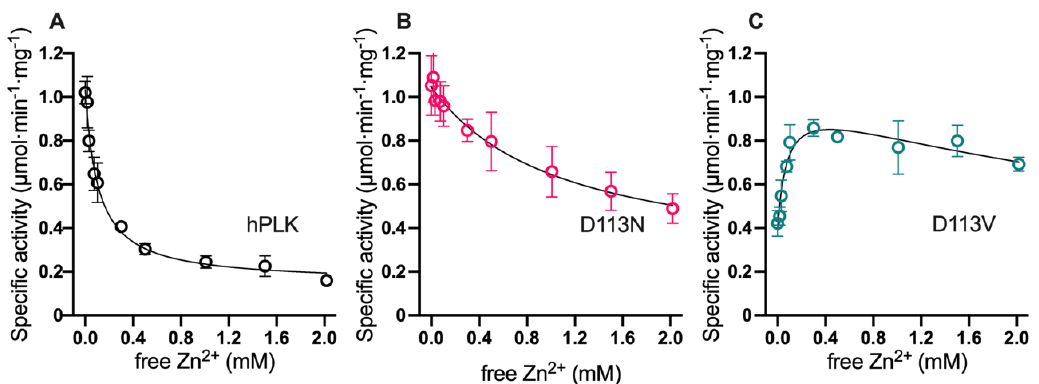
Figure 3. E ff ect of free Zn 2 + concentration on the activity of hPLK and DPV mutants. ( A ) Inhibitory Figure 3. Effect of free Zn 2+ concentration on the activity of hPLK and DPV mutants. ( A ) Inhibitory e ff ect of free Zn 2 + on wild type hPLK. ( B ) Inhibitory e ff ect of free Zn 2 + on D113N mutant. ( C ) Inhibitory effect of free Zn 2+ on wild type hPLK. ( B ) Inhibitory effect of free Zn 2+ on D113N mutant. ( C ) Inhibitory e ff ect of free Zn 2 + on D113V effect of free Zn 2+ on D113V mutant.